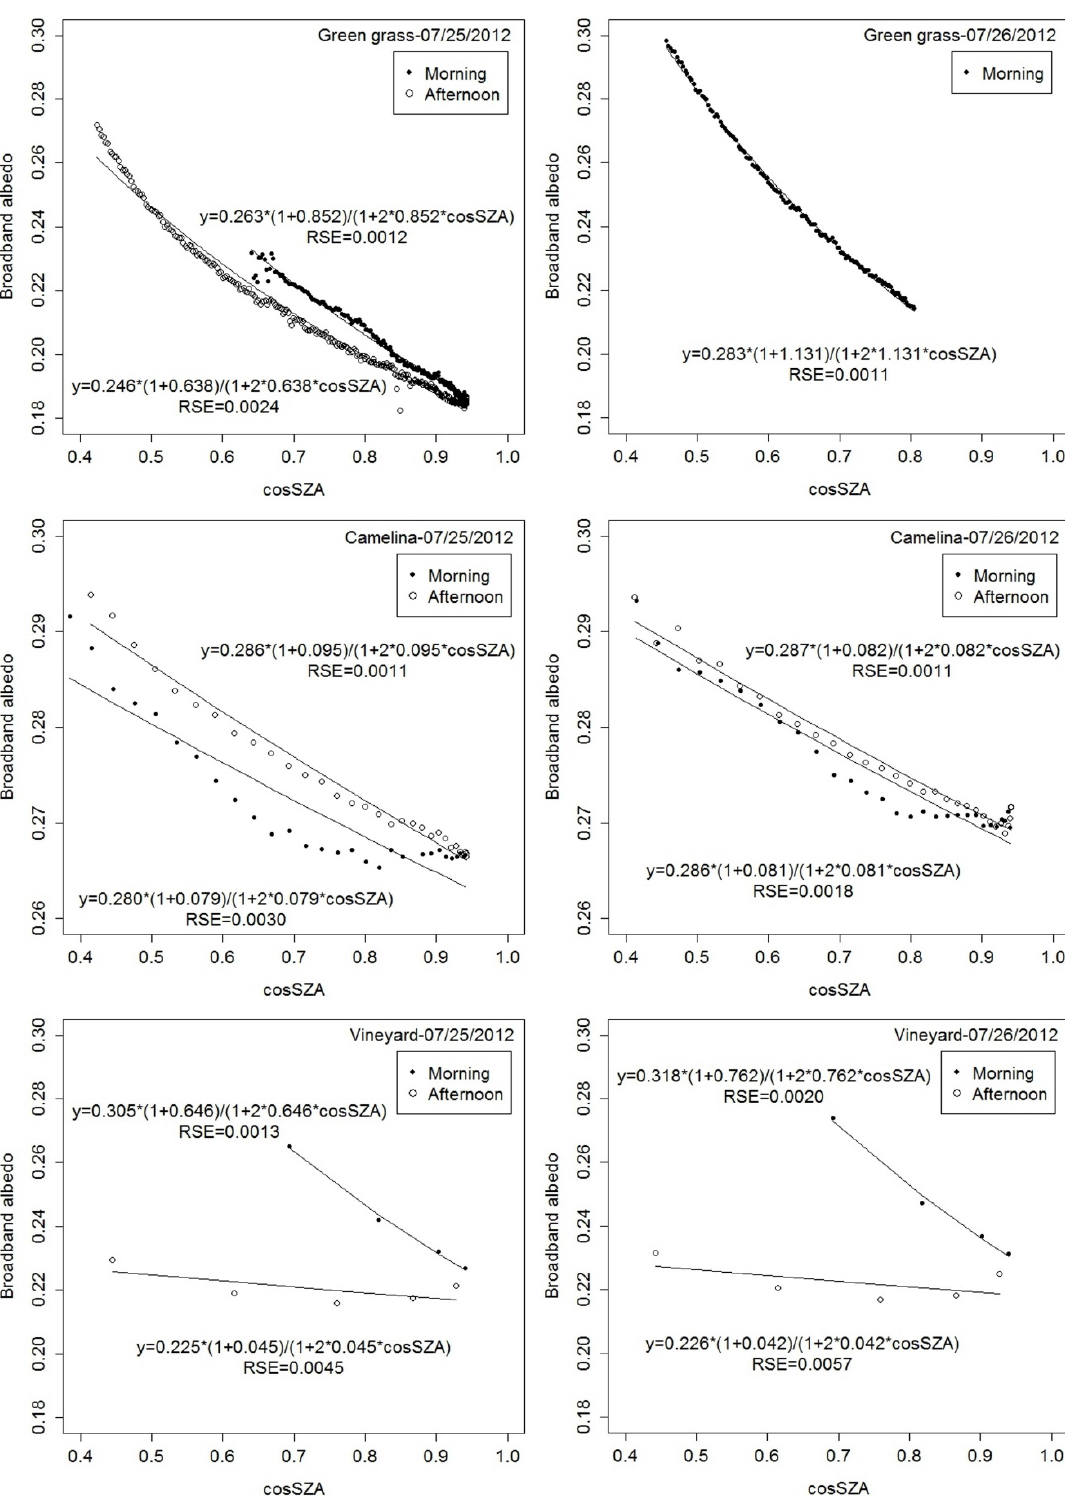
Figure 5. Broadband albedo measured at the green grass, camelina, and vineyard sites. The fits to the parameterization model are also shown.